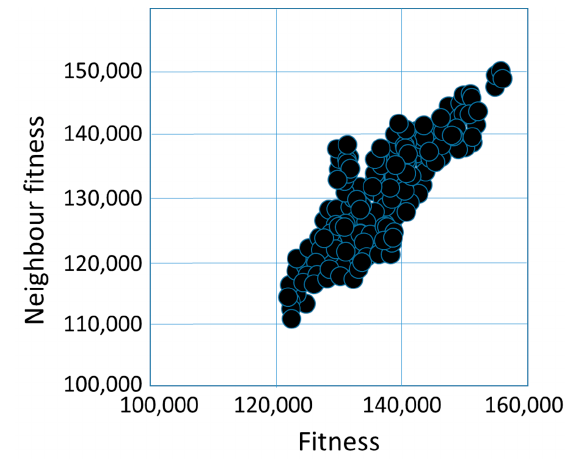
Figure 9. The fitness cloud for order crossover operator. Table 7. Order crossover distances results.